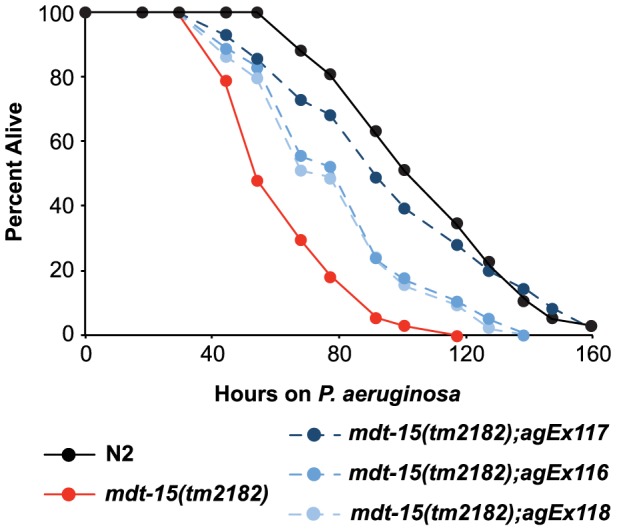
MDT-15 is required for defense against P. aeruginosa infection.A P. aeruginosa pathogenesis assay with wild-type N2, mdt-15(tm2182) mutant worms and mdt-15(tm2182) animals carrying pmdt-15::mdt-15 (three independent lines agEx116, agEx117 and agEx118) is shown. The difference in P. aeruginosa susceptibility between mdt-15(tm2182) animals and each of the three transgenic lines carrying pmdt-15::mdt-15 is significant, as is the survival difference between N2 and mdt-15(tm2182) animals (p<0.001). For sample sizes, see Table S3.